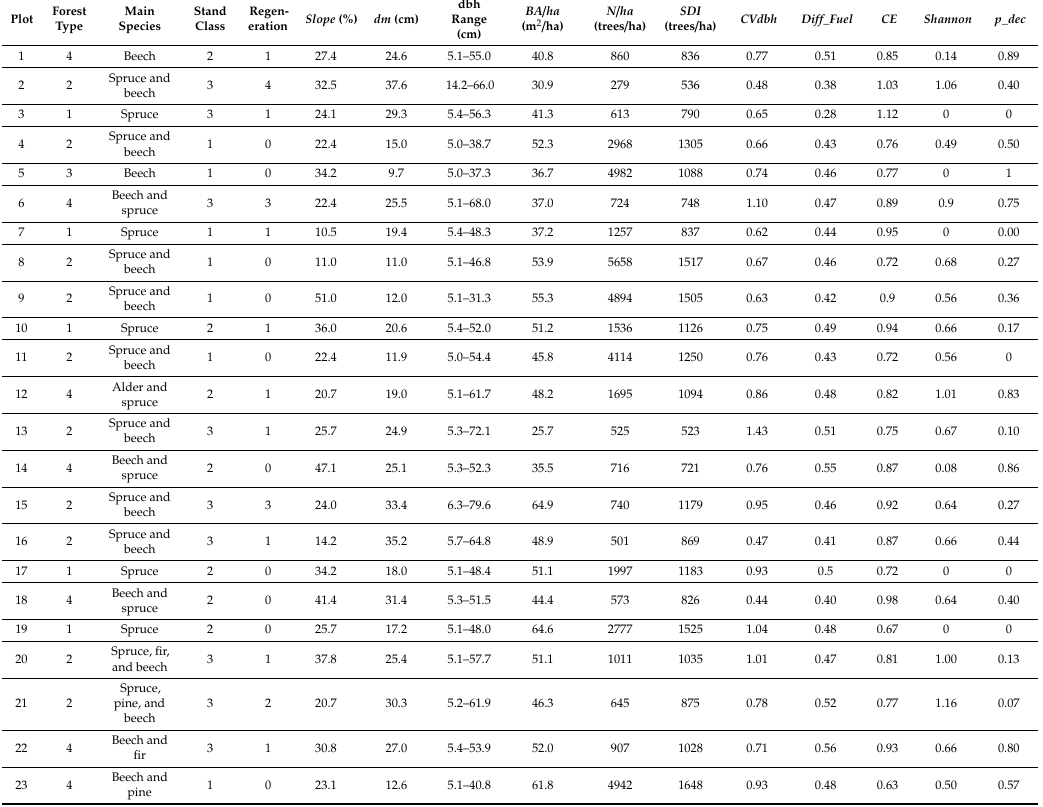
Table A1. Plot descriptions of the 23 sample plots. Summary statistics of sample plots. slope , slope of sample plot; dm , diameter of mean basal area tree; BA / ha , basal area per hectare; N / ha , number of trees per hectare; SDI , stand density index; CVdbh , coe ffi cient of variation of diameter at breast height; Dif f _ Fuel , dbh di ff erentiation according to Füldner; CE , Clark and Evans aggregation index; shannon , Shannon index; p_dec, proportion of deciduous